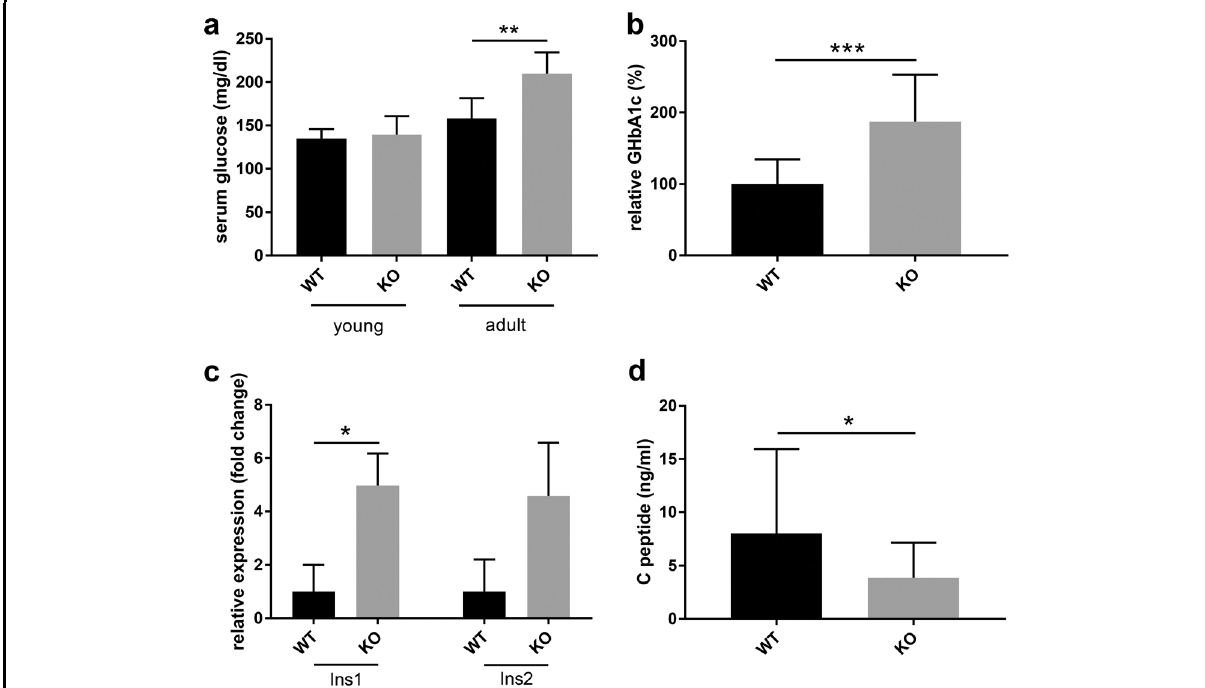
Fig. 4 Exocrine pancreatic Cosmc KO induces diabetes in adult mice. a Measurement of fasting serum blood glucose in young animals ( n = 10; P = 0.58) and adult mice ( n = 15; P = 0.0005). b Quanti fi cation of HbA1c con fi rms diabetes in adult Cosmc- KO mice ( n = 15 each; P < 0.0001). c Quantitative PCR analysis of Ins1 and Ins2 from total WT and Cosmc- KO pancreas mRNA ( n = 3) indicates insulin overexpression by a factor of 5.0 ( P = 0.025) and a factor of 4.58 ( P = 0.053), respectively, in Cosmc KO. d Absolute C-peptide quanti fi cation in sera from WT ( n = 18) and Cosmc- KO ( n = 19) adult mice shows reduced C-peptide expression in Cosmc- KO mice ( P =